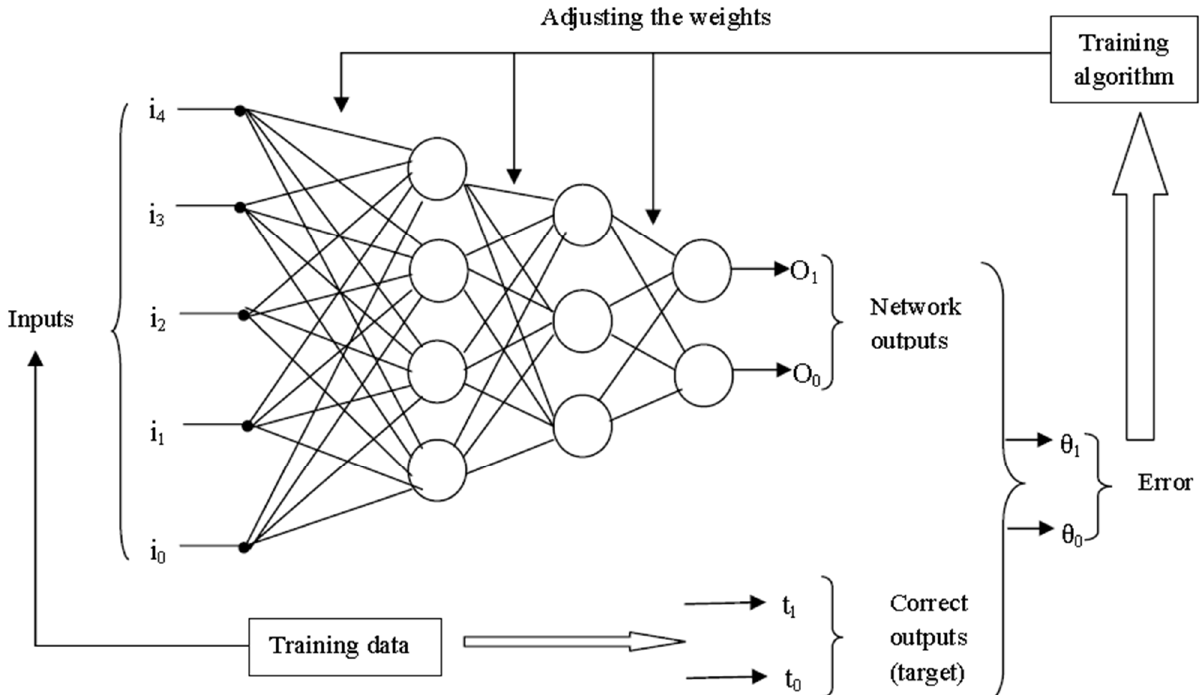
Figure 6. MLP architecture.